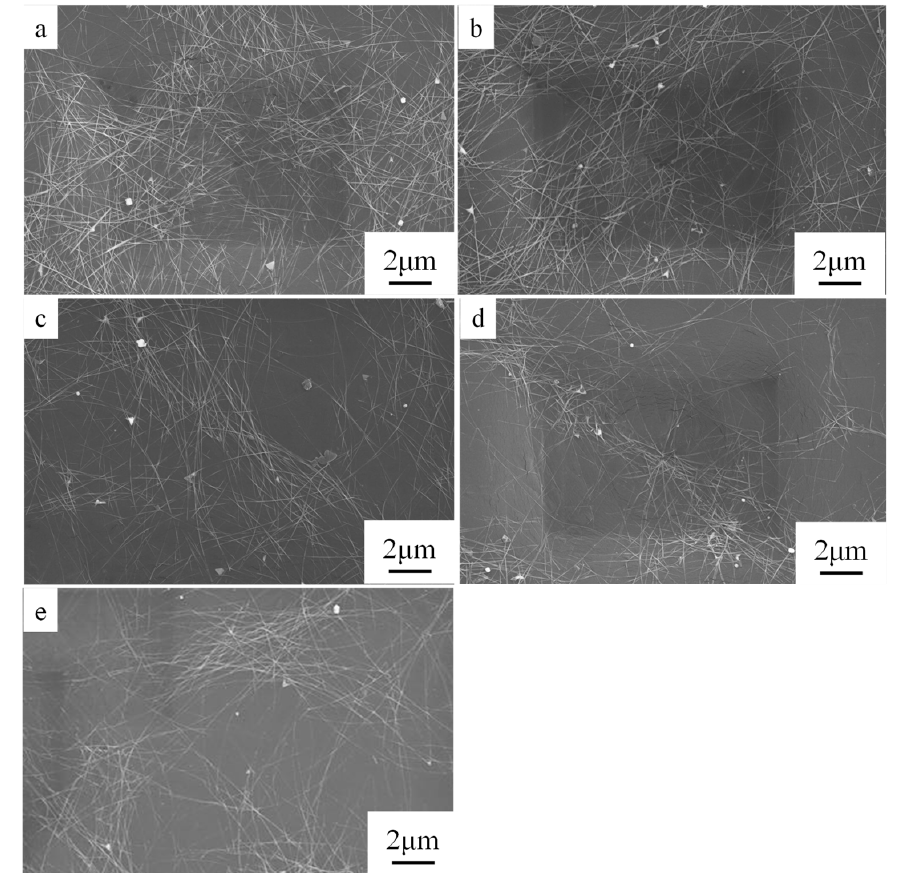
Figure 7. SEM images of AgNW films consisting of AgNWs with length of ( a ) 15.5 μ m, ( b ) 9.48 μ m, ( c) 9.24 μ m, ( d ) 8.95 μ m, and ( e ) 7.86 μ m. ( c ) 9.24 µ m, ( d ) 8.95 µ m, and ( e ) 7.86 µ